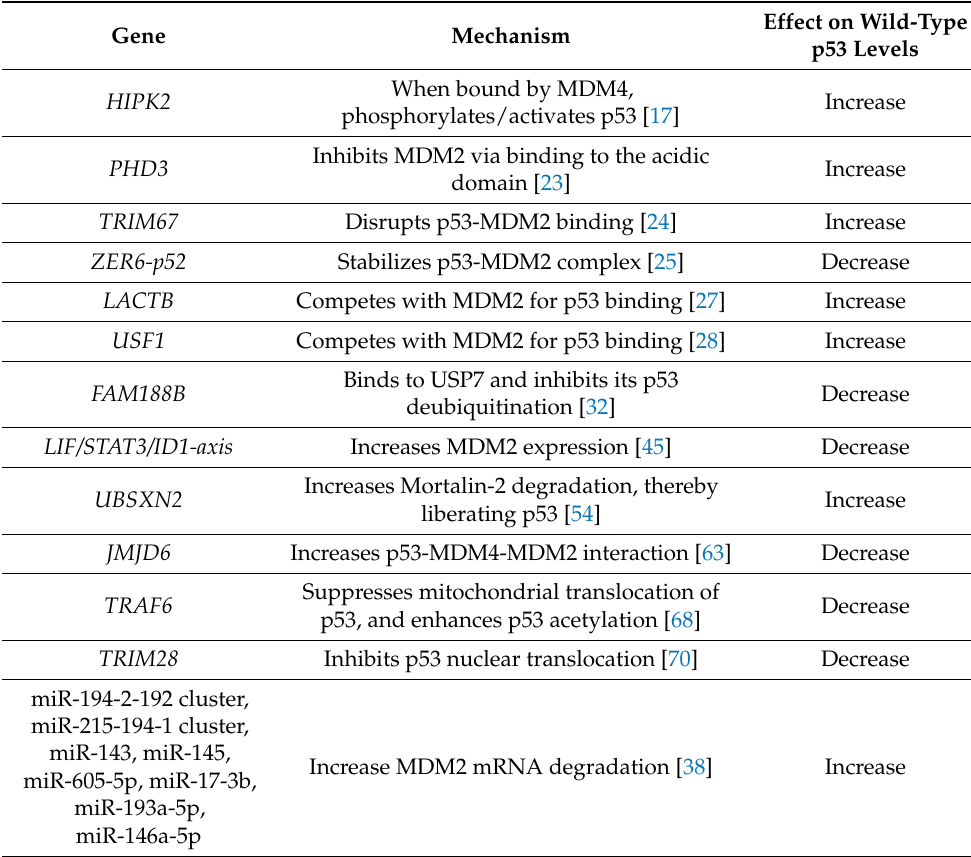
Table A1. Newly identified modulators of the p53